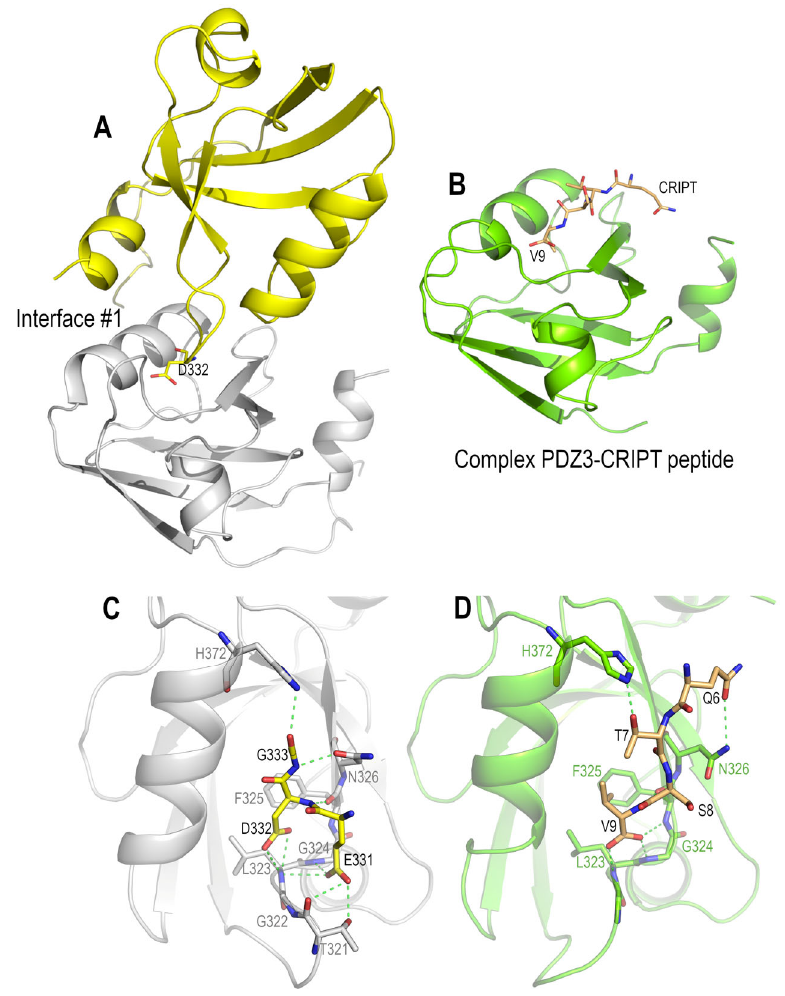
Figure 7. Comparison of the first crystal interface and the complex between PSD95-PDZ3 and CRIPT peptide (KQTSV) (PDB entry 1BE9). For the sake of clarity, only the interface in the orthorhombic-A structure is shown: ( A ) the main crystal interface (interface #1) of the orthorhombic-B (molecule 1, yellow; molecule 2, white). Asp332 is shown in sticks. ( B ) The complex structure of the PSD95-PDZ3 (cartoon, green) and CRIPT peptide (sticks, orange). The C-terminal residue, V9, is shown. ( C ) Contacts between residues Glu331-Asp332-Gly333 (sticks, yellow) and the canonical binding site of the symmetry-related molecule in the crystal interface. ( D ) Contacts between residues in the CRIPT peptide and the canonical binding site. Hydrogen bonds are shown in green dashed lines.